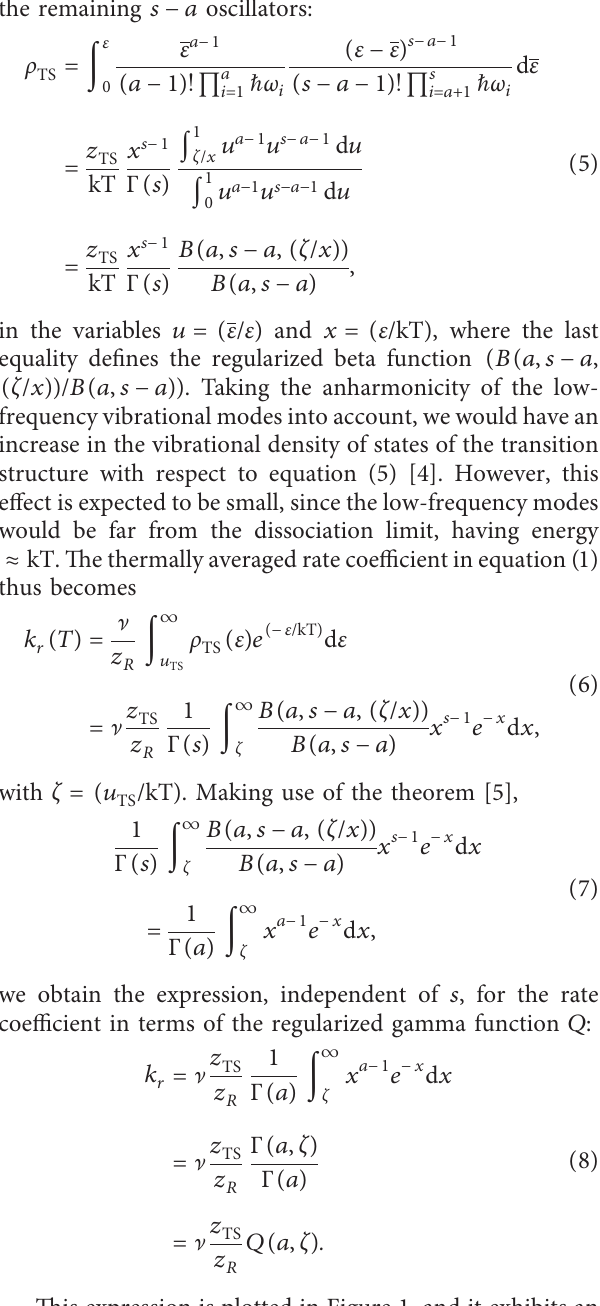
reactions indicates that ( a / ζ ) ≃ 0 . 9, and the most common values of Q ( a, ζ ) are slightly less than 1/2, since a typical value of the reduced